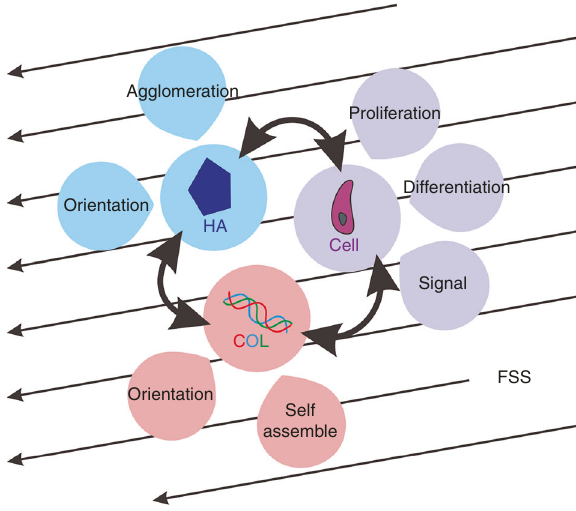
Fig. 7 Mechanobiology of the bone matrix. Col, HA and bone- related cells were exposed to FSSs of 0.5 to 3.0